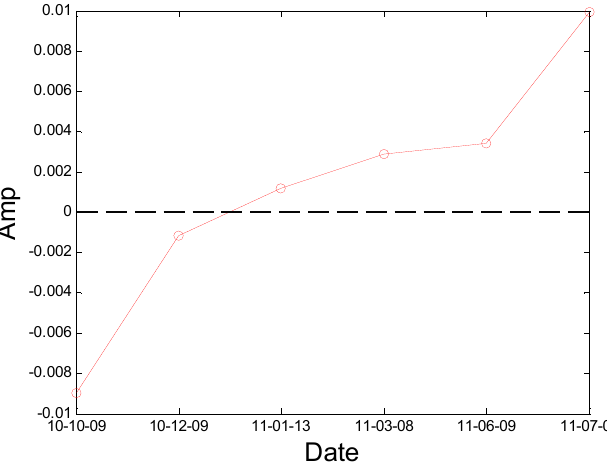
Figure 20. The LLE value of A fan No. 3H sensor.